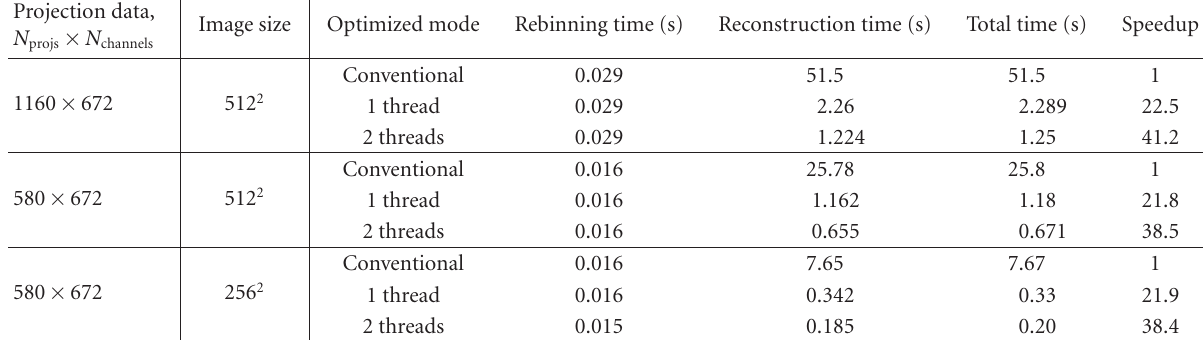
Table 3: Speedup comparison on HP 4300 workstation (one Pentium D 840 processor).